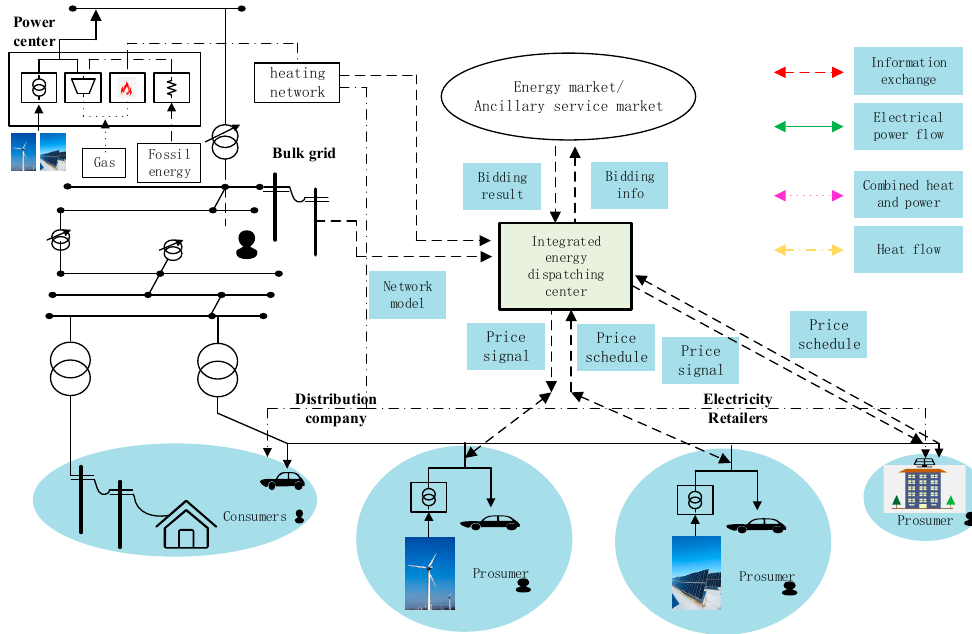
Figure 1. The multi-energy coordination system architecture of an urban power grid.